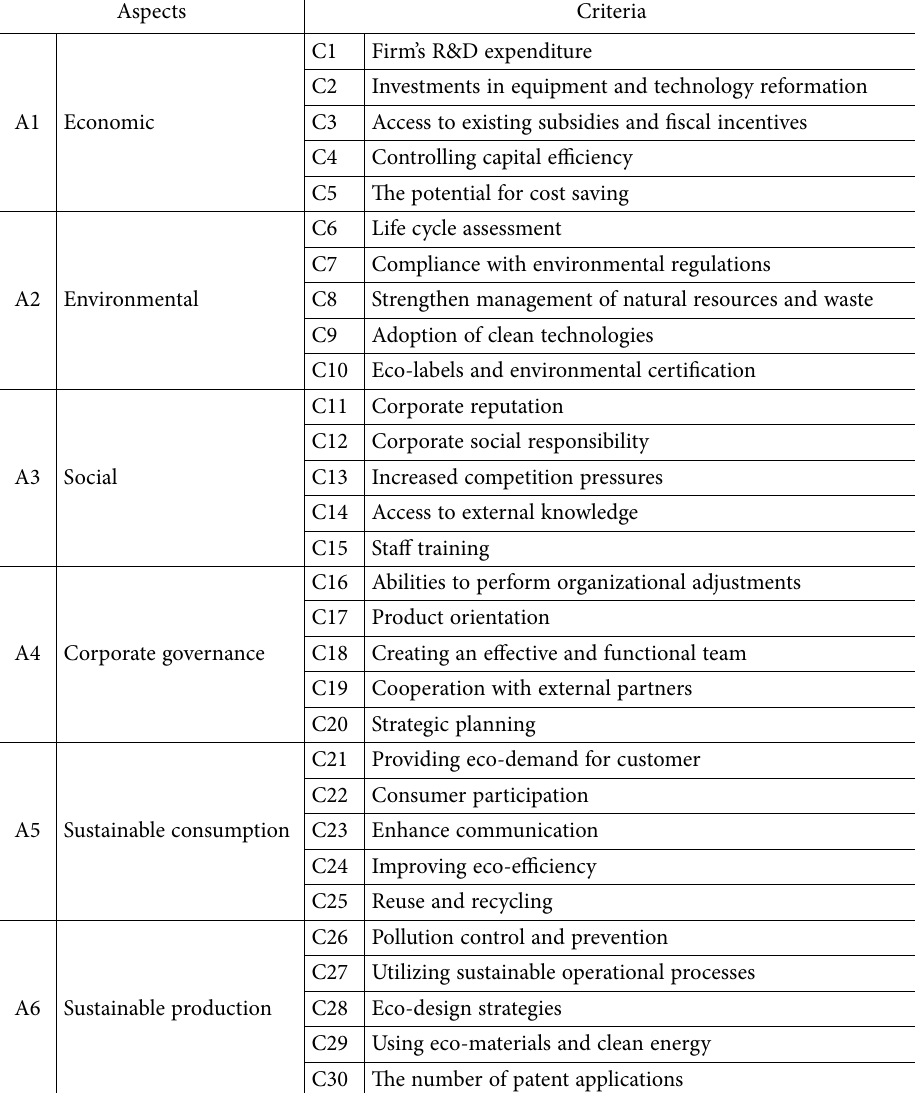
Table 1. Evaluation aspects and criteria for